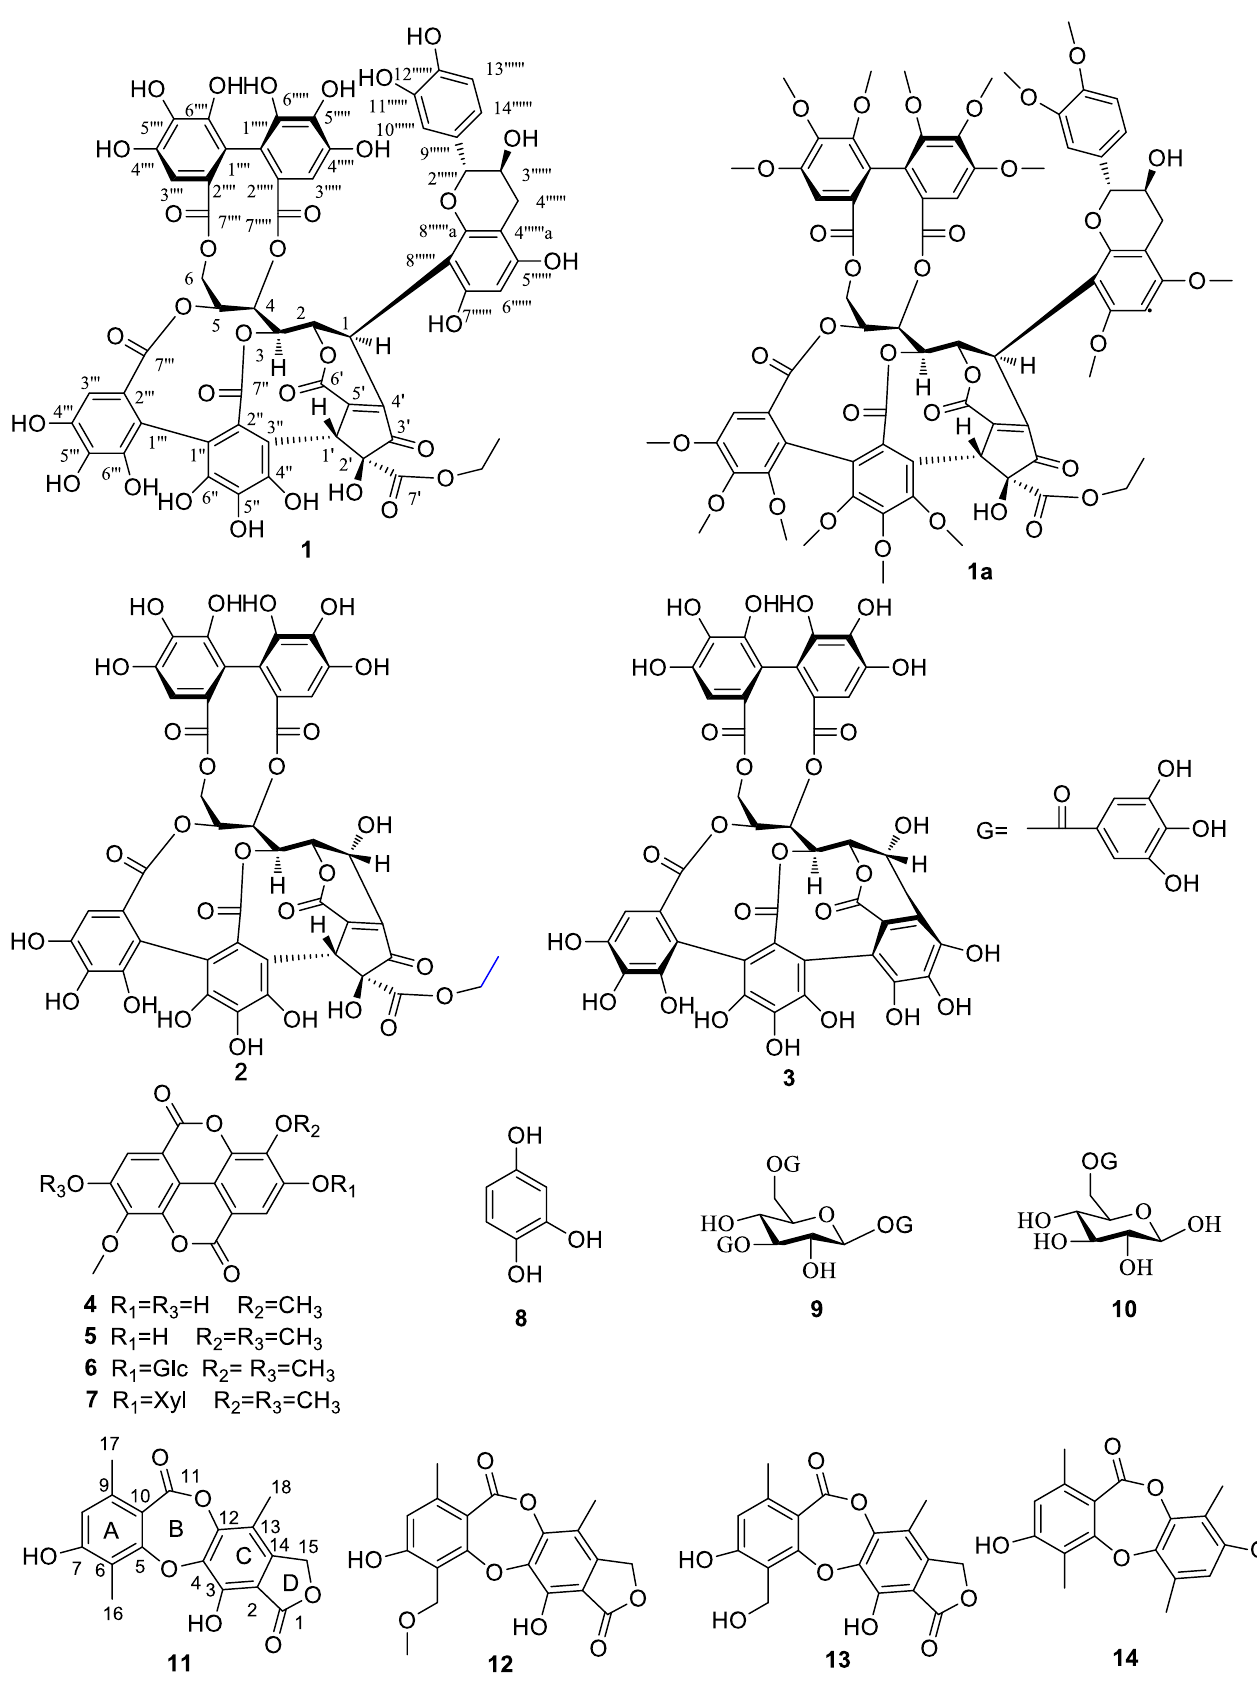
Figure 1. Structures of compounds 1 – 14 .